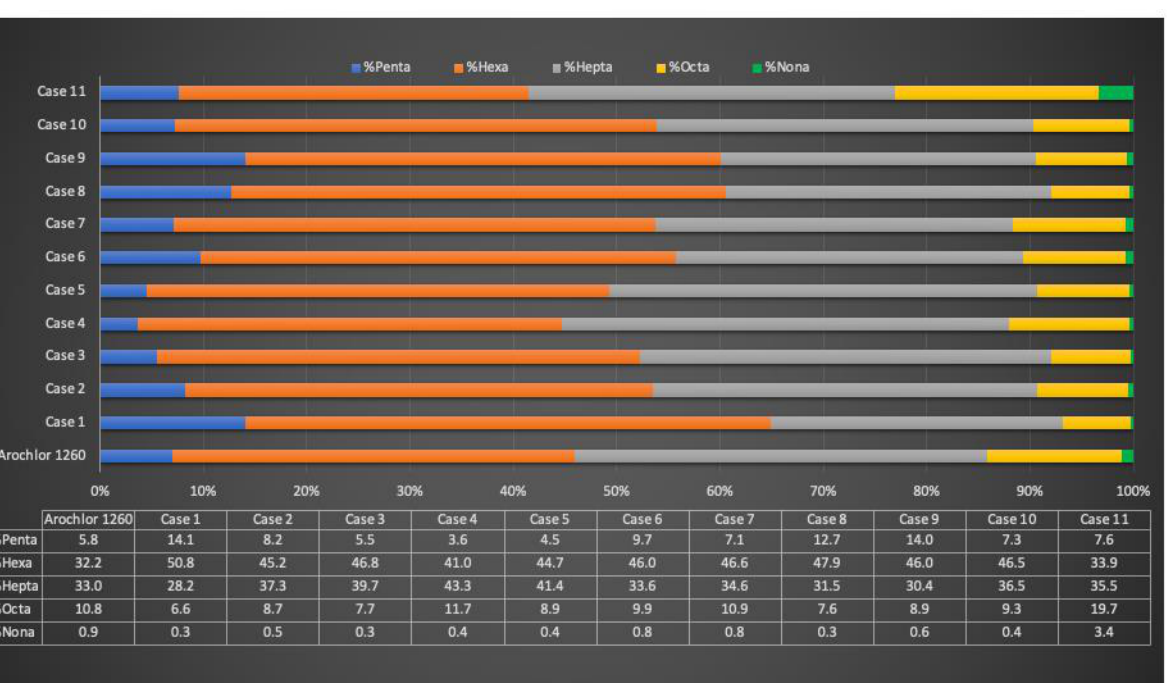
Figure 5. PCB fingerprint (% on Total PCBs) in the 11 specimens of bottlenose dolphin. The red dotted indicator point highlights the fingerprint of Case 11. Regarding DDTs, a typical technical DDT is composed of pp’DDT (77.1%), the nearly inactive op’DDT (14.9%), pp’DDD (0.3%), op’DDD (0.1%), pp’DDE (4.0%), op’DDE (0.1%), and unidentified compounds (3.5%) [92]. DDE and DDD are also the main environmental